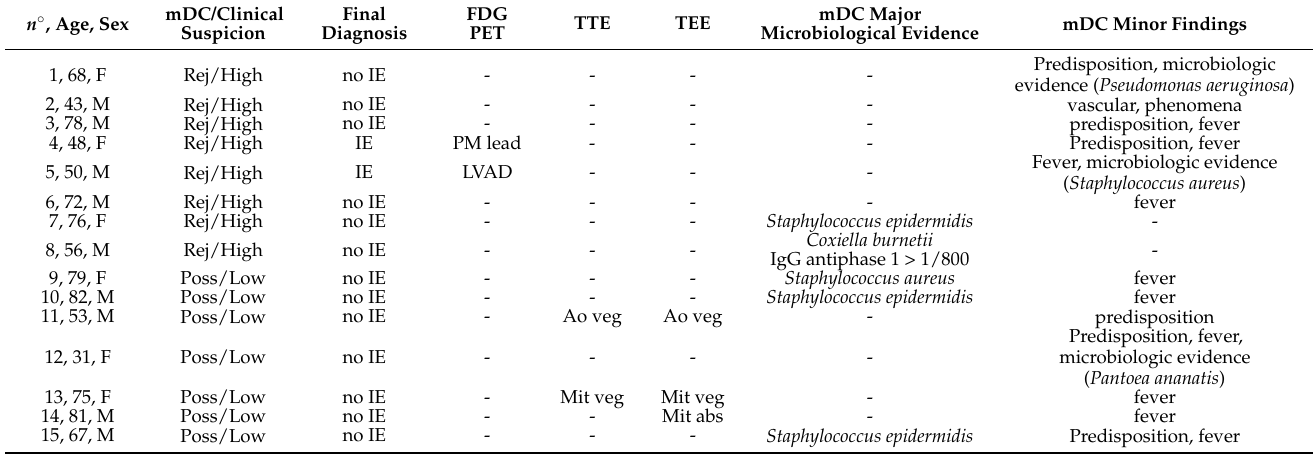
Table 4. Fifteen patients with the strongest classification discordances, including Duke 0/high suspicion ( n = 8) and Duke 1/low suspicion ( n = 7). mDc: modified Duke Criteria; IE: infective endocarditis; Rej: mDC rejected IE; Poss: mDC possible IE; PM: pace-maker; LVAD: left ventricular assistance device; TTE: transthoracic echography; TEE: transesophagus echography; Ao veg: aortic valve vegetation; Mit veg: Mitral valve vegetation; Mit abs: mitral abscess. n ◦ , Age,